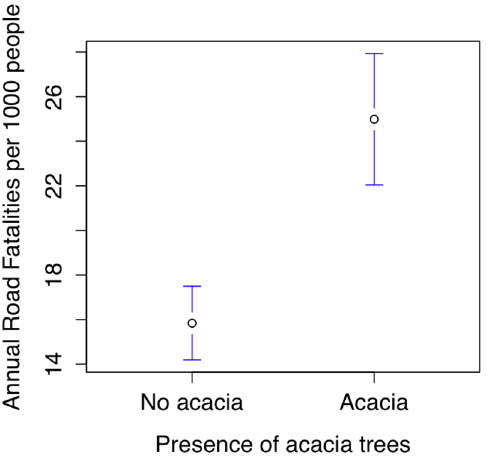
Figure 9. The mean number of annual road fatalities per 100,000 people within a country as a function of the presence of Acacianilotica .